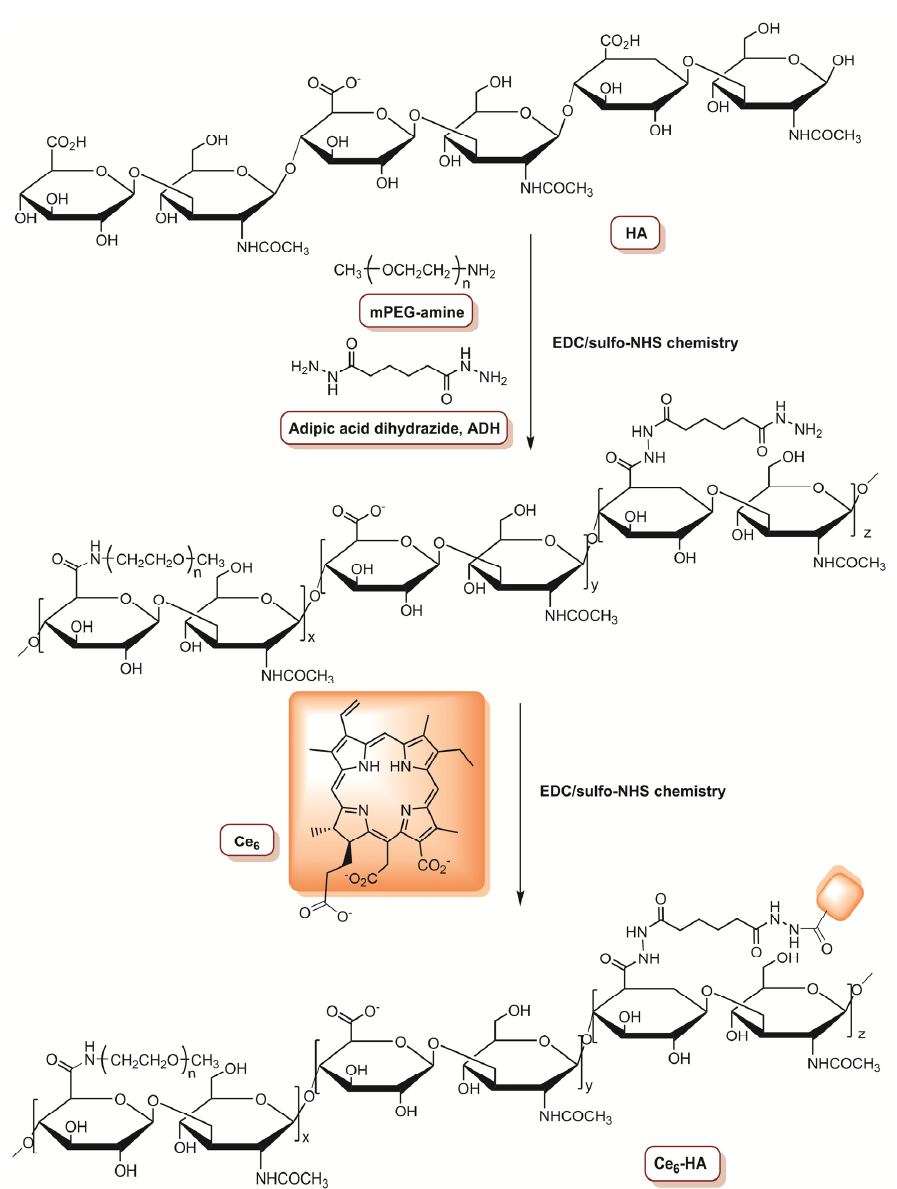
Figure 3. Schematic representation of the preparation of Ce 6 -HA (adapted from Reference [74]).